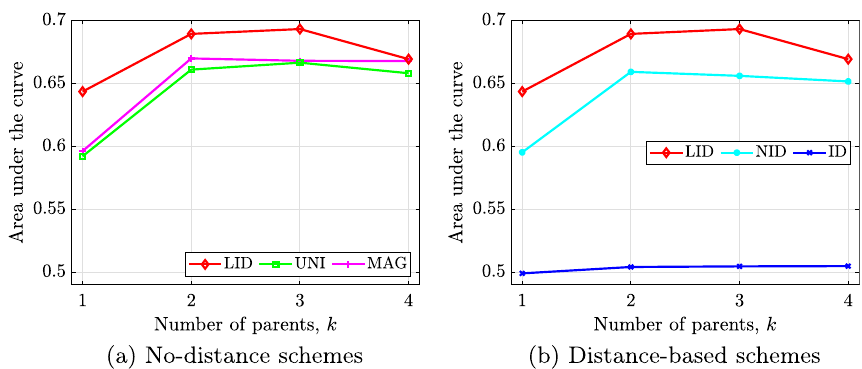
Fig. 1 Ranking accuracy using different weighting